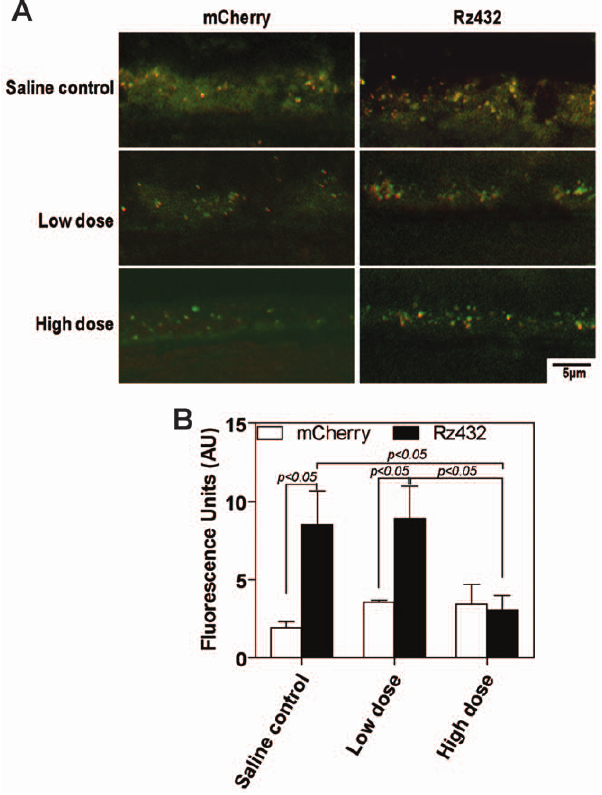
Figure 8. 8-OH DPAT decreases RPE autofluorescence in SOD2 knockdown eyes of mice. Eyes received injection of AAV- SOD2 ribozyme or AAV-mCherry and animals received subcutaneous 8-OH DPAT or saline control for up to 4 months. A - Confocal fluorescence microscopy of the RPE layers from AAV-mCherry and AAV-ribozyme treated eyes treated with saline, low dose or high dose of 8-OH DPAT. B - Treatment with 8-OH DPAT lowered autofluorescence in oxidatively stressed RPE in mice. Mice were injected with AAV-mCherry or AAV- Rz SOD2 -mCherry and analyzed after 4 months of daily injections of saline (no treatment) low dose or high dose of 8-OH DPAT. * P , 0.05, **P , 0.01 (compared to AAV-RzSOD2 control).